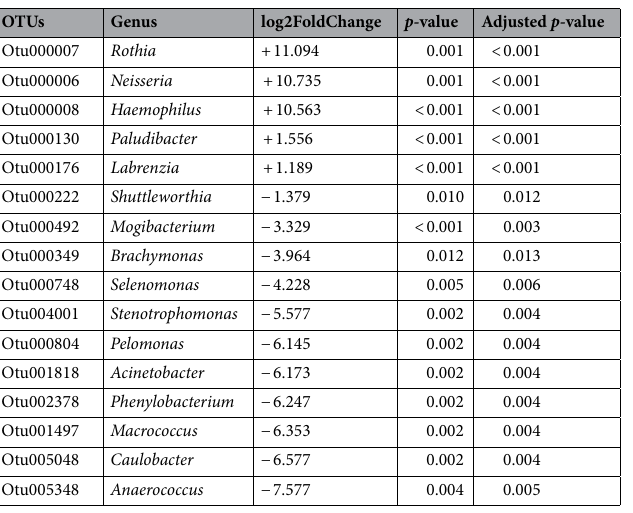
Table 3. List of differentially abundant genera in boys in caries group compared with cavity free group. log2FoldChange value (+) means higher and (–) means lower abundancy in caries group compared with cavity free